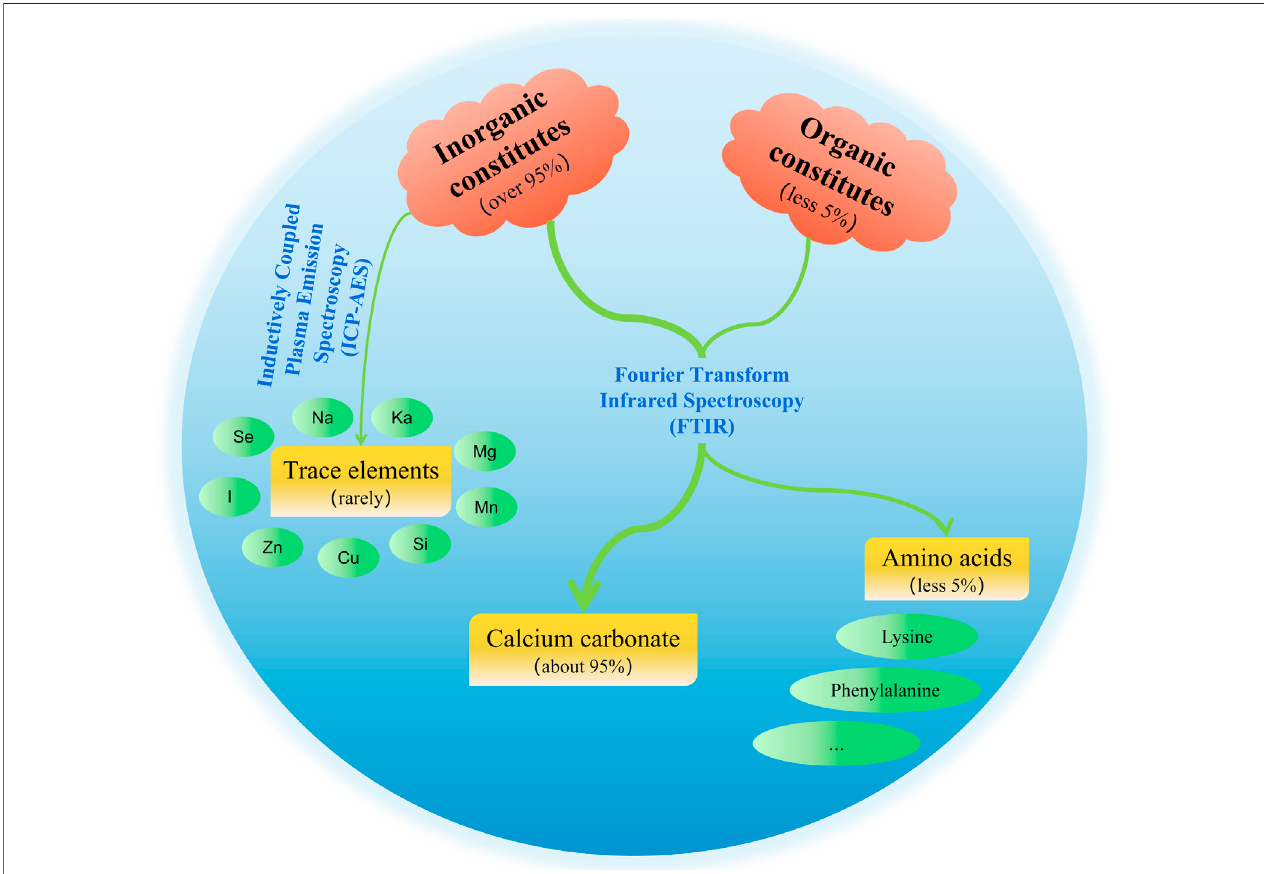
FIGURE 1 | Schematic diagrams of chemical constituents and test methods of